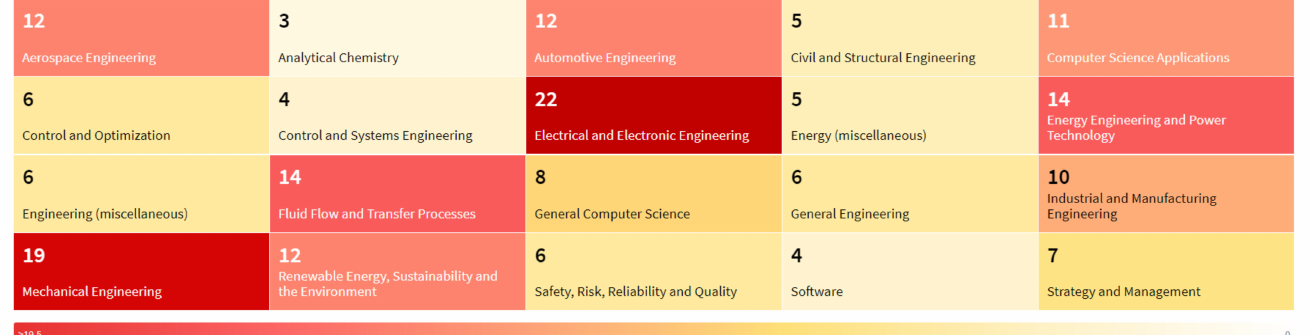
Figure 8. Top 20 most frequent subjects in papers of The Lens.